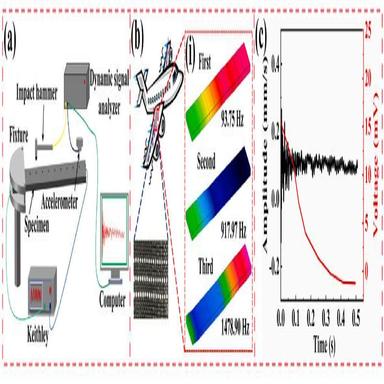
(a) Schematic diagram of modal test equipment. (b) The natural frequency of the vibration modal shapes of the 3DOPC. (c) Response relationship between 3DOPC vibration amplitude and generated electrical signal during modal testing.